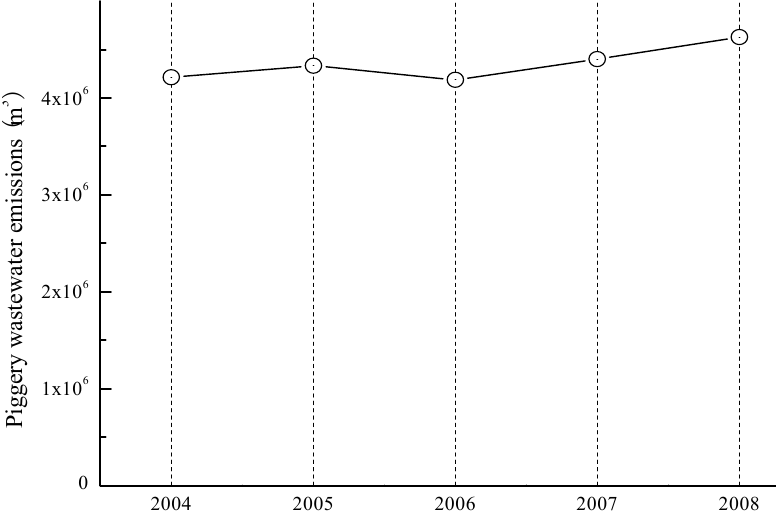
Figure 4. Piggery wastewater emissions in China.